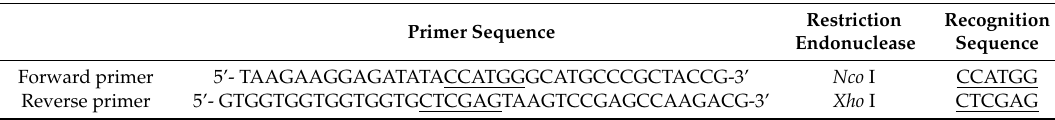
Table 3. Primer sequence for Error-Prone PCR.